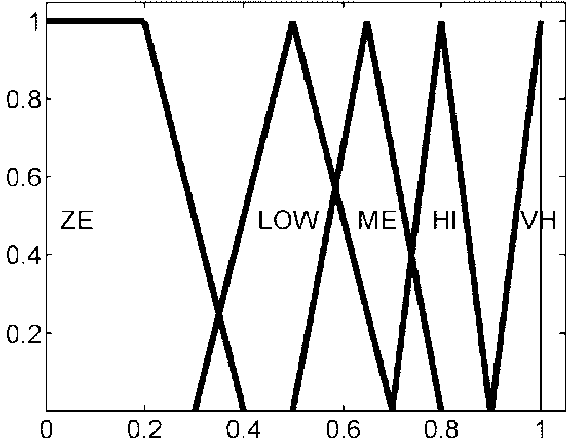
Figure 7. Membership functions of fuzzy sets in weight 𝐽 (cid:3038)(cid:3036) .